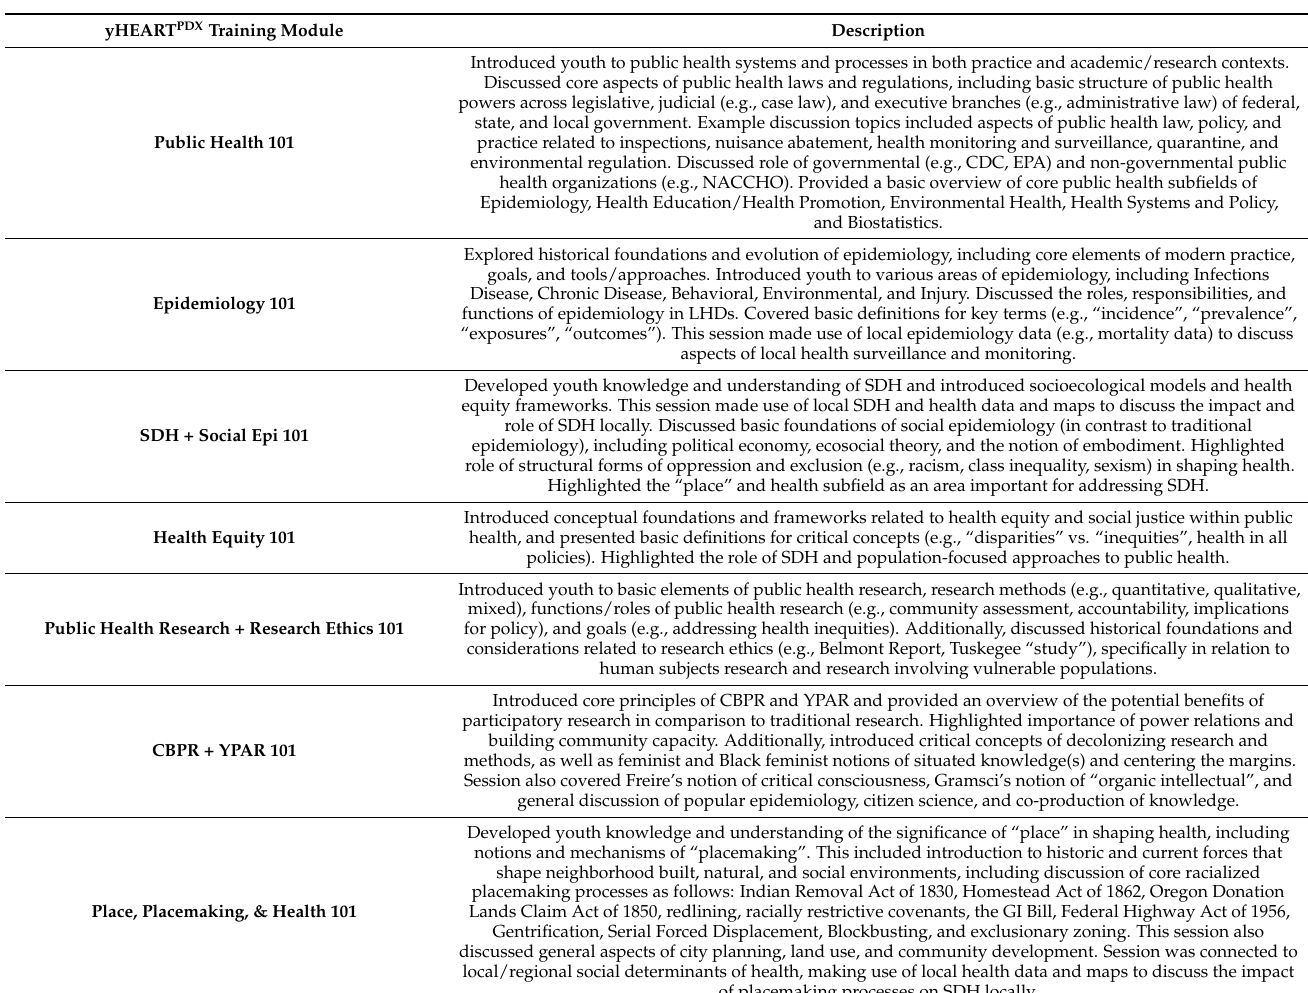
Table 1. Summary of yHEART PDX training modules for yHEART PDX , Vol.I: Youth Participatory Research on Local Social Determinants of